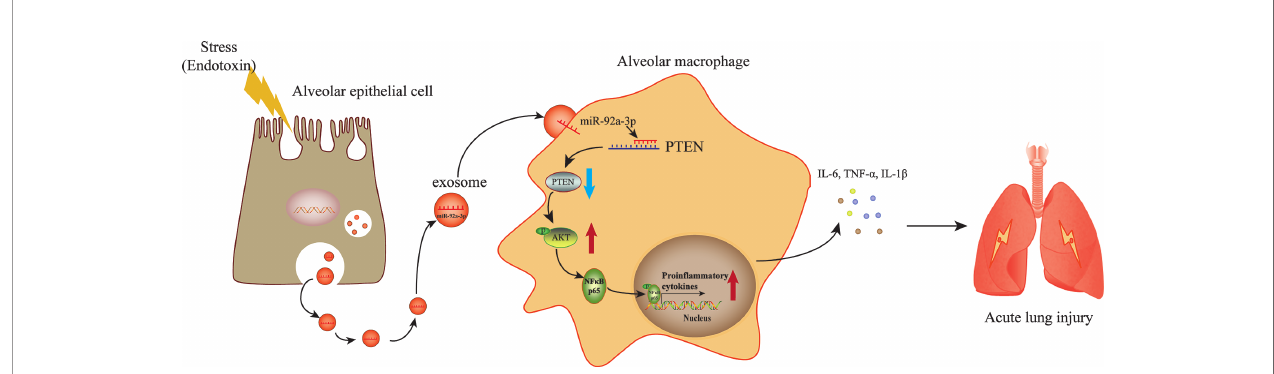
FIGURE 7 | A schematic diagram showing the role of exosomal miR-92a-3p from LPS-induced AECs in inducing AM activation in septic lung injury. LPS stimulation induces AECs to release an increased number of exosomes, which are enriched with miR-92a-3p. The AEC-derived exosomes are taken up by AMs. miR-92a-3p induced degradation of the PTEN mRNA in AMs, resulting in the downregulation of the PTEN protein level and subsequent activation of the NF- k B signalling pathway. The nuclear translocation of p65 further promotes the release of proin fl ammatory factors